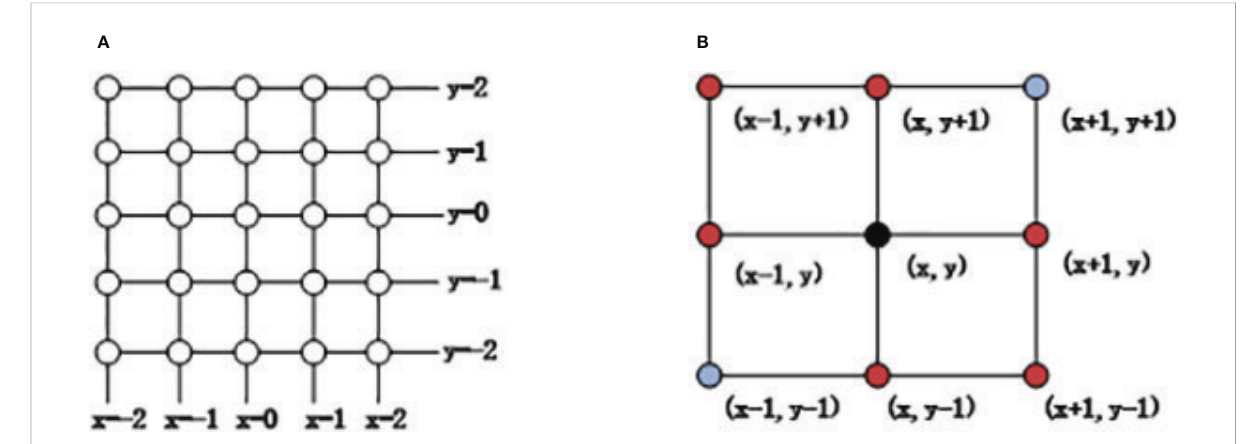
FIGURE 7 Labeling based on geographical locations of nodes. (A) Node coordinates (B) Coordinate value relations of neighboring